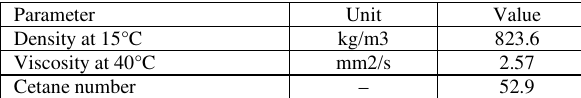
Table 1. Diesel oil properties